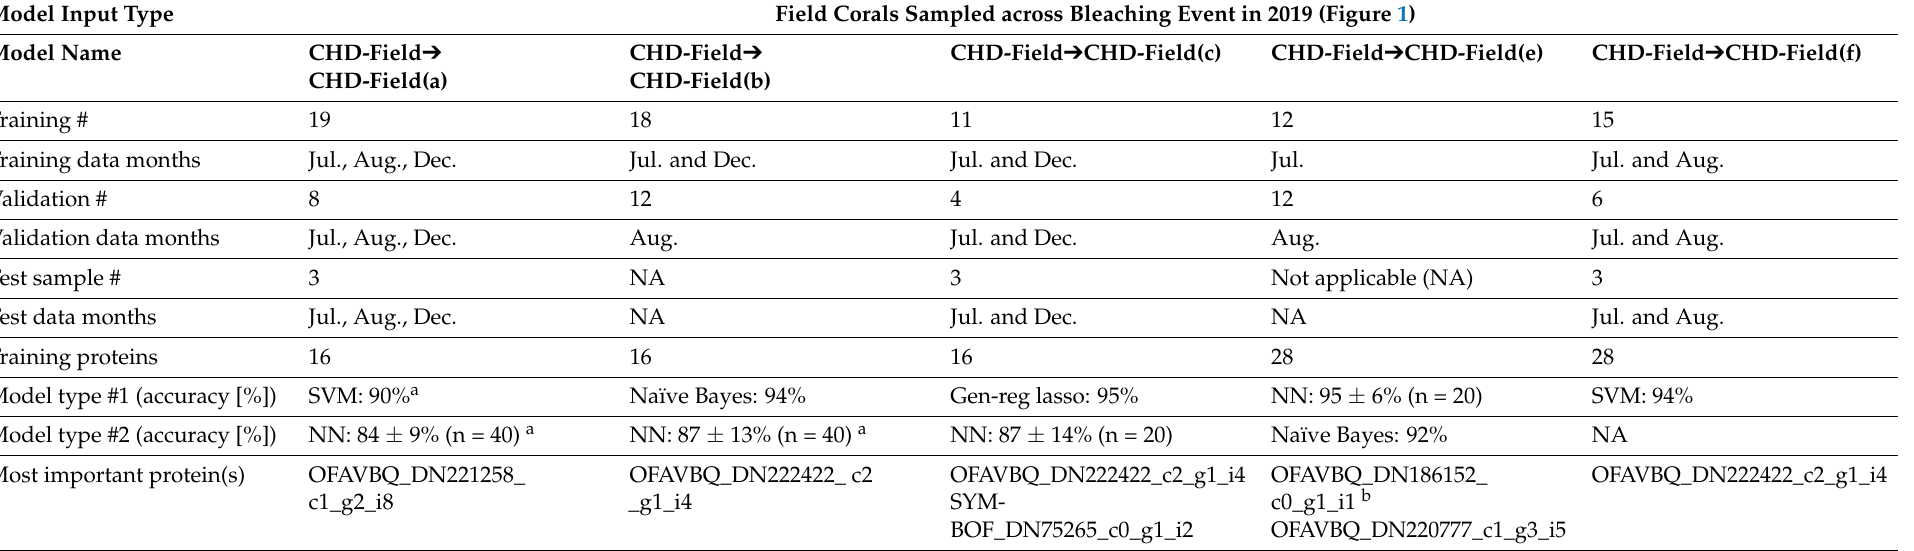
Table 5. Models for predicting coral colony health designation (CHD) from field coral data exclusively. Of the 65 proteins identified in the July (pre-bleaching) samples, only 28 were also quantified in the August (bleaching event) samples, of which 16 (11 host & 5 Symbiodiniaceae) were also quantified in the December (post-bleaching) samples; 5 of these were also found in the lab samples. Models with accuracies <80% are found in Supplementary File S2. When the superior model was a neural network (NN), 10–20 simulations were run to accommodate having considered up to 100 tours, with the mean ± standard deviation shown in the cell. The “most important protein(s)” was/were derived from a dependent resampled inputs analysis. Gen-reg = generalized regression. SVM = support vector